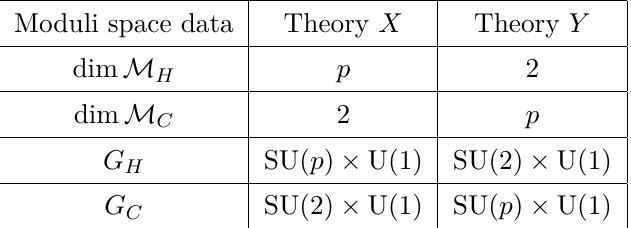
Table 12 . Summary table for the moduli space dimensions and global symmetries for the mirror pair in figure 36.